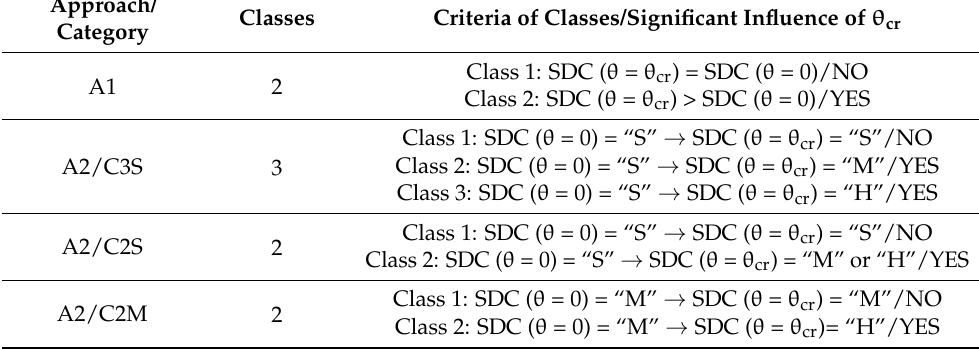
Table 2. Main characteristics of the approaches used for the definition of the studied problem.